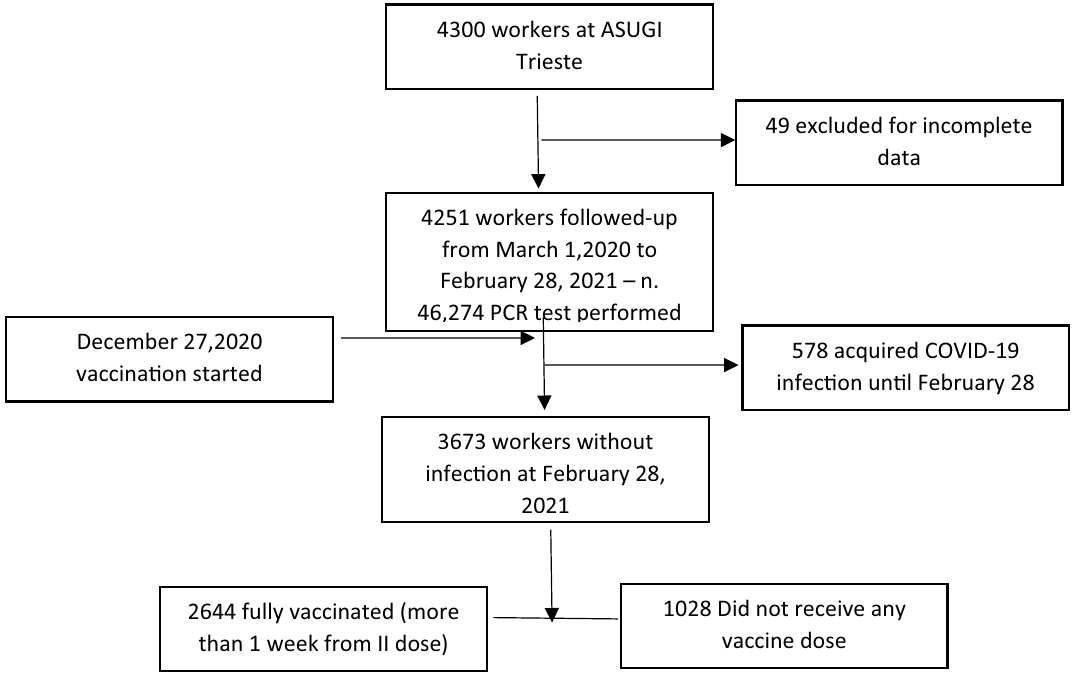
Figure 1. Study cohort analyzed (PCR = polymerase chain reaction in nasopharyngeal